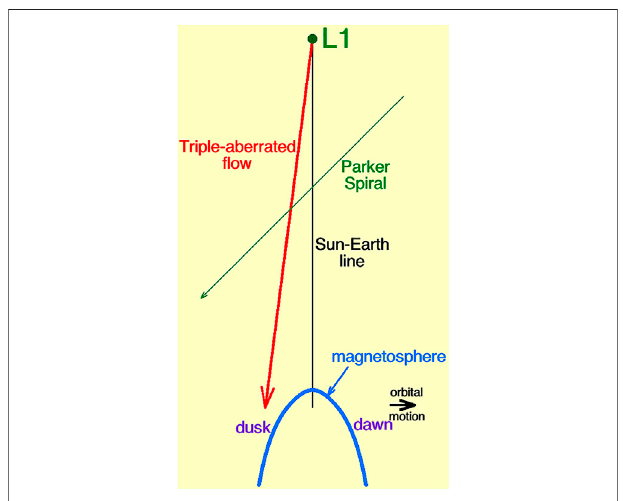
FIGURE 1 | A sketch of a net duskward aberration (red arrow) from a monitor at L1 (green).